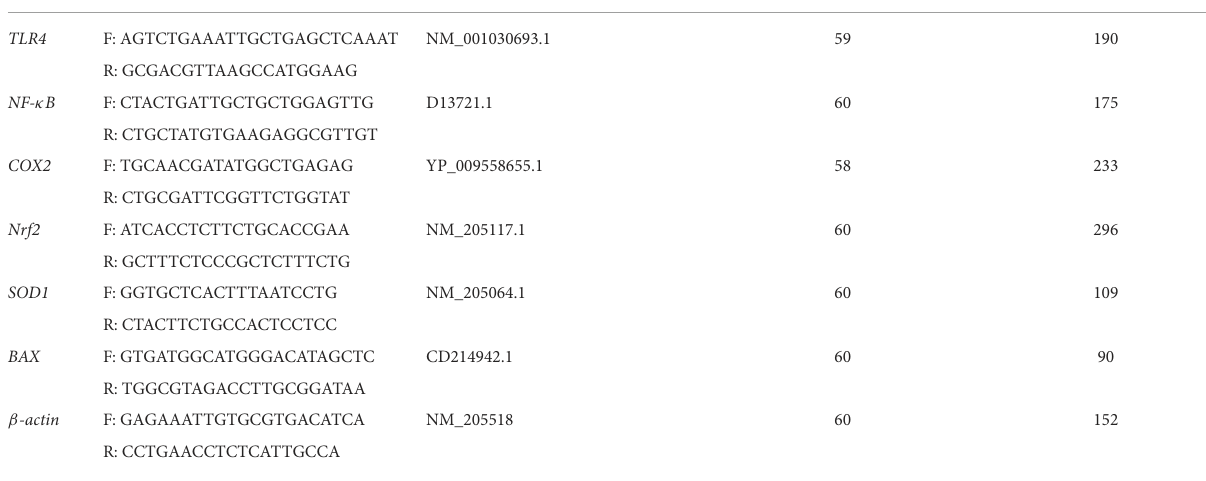
TABLE 2 Primer sequences for quantitative real-time